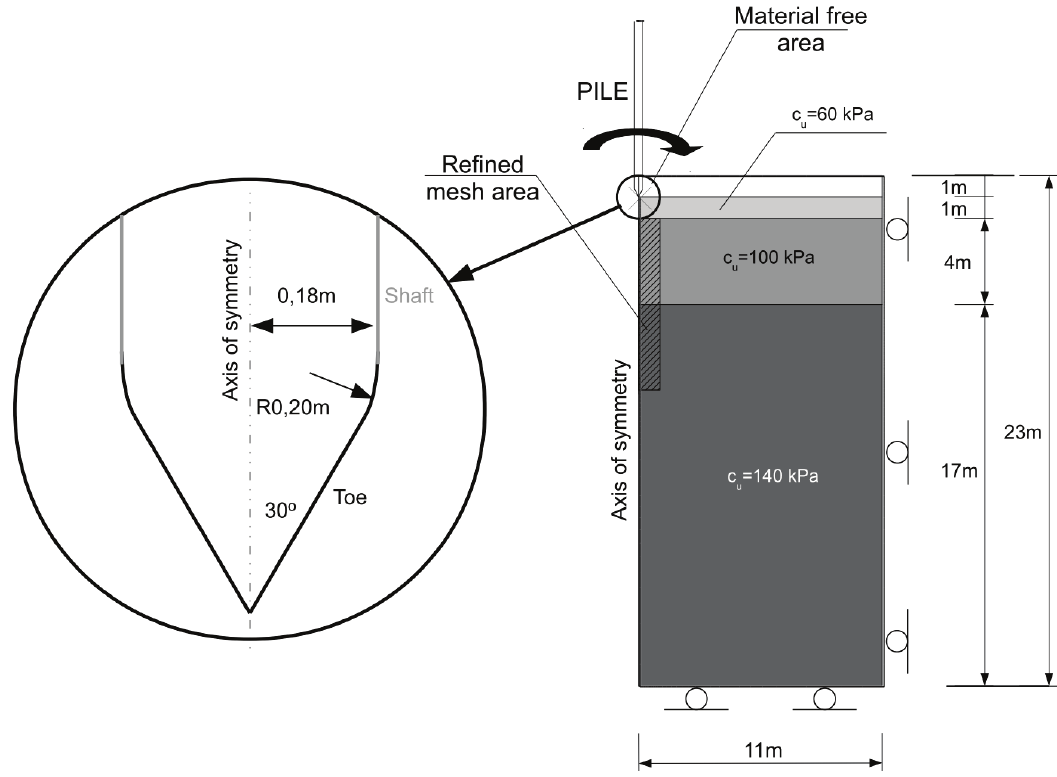
Fig. 7. CEL numerical model